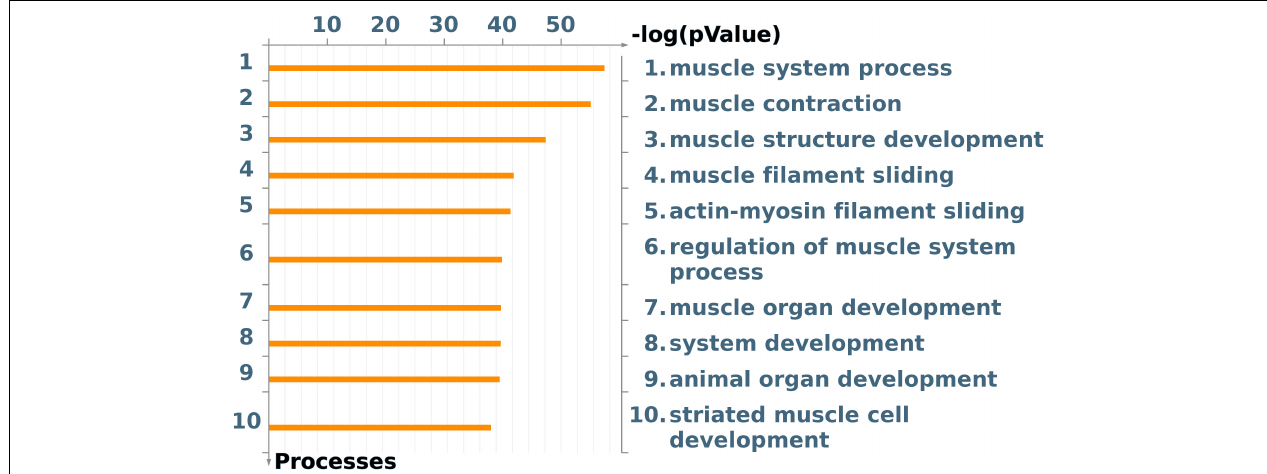
FIGURE 4 | Gene Ontology terms showing the top 10 significant ( p < 0.05) processes that the DE genes are related to. Image created by MetaCore software.